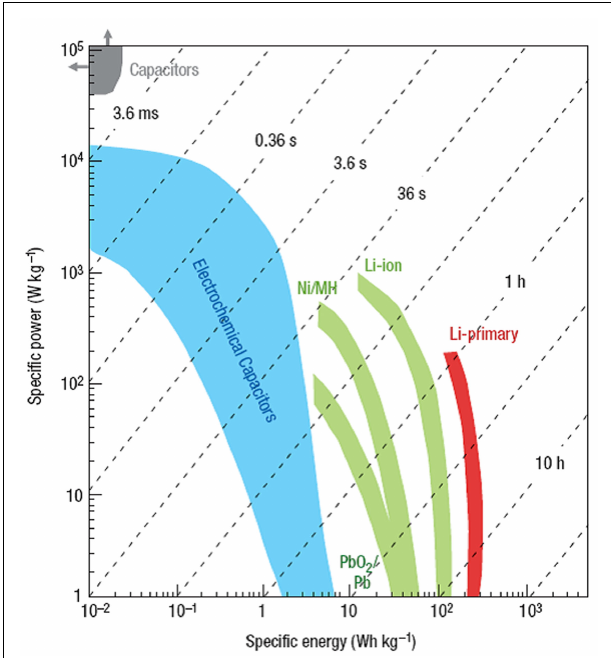
FIGURE 1 | Specific power against specific energy, also called a Ragone plot, for various electrical energy-storage devices . The shaded curves were obtained from Simon and Gogotsi